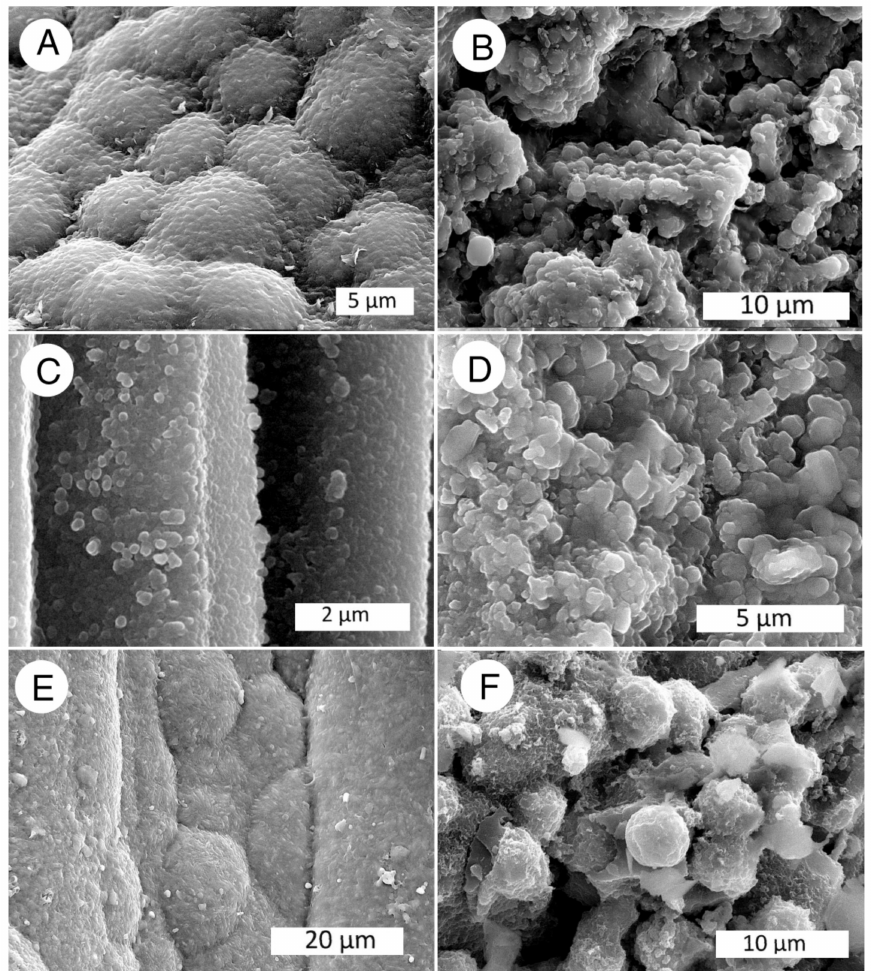
Figure 44. SEM images showing relict textures in silicified wood. ( A , B ) Chalcedony-mineralized Protoyucca wood showing relict opal lepisphere morphology, Miocene, Badger Flat, northeastern Nevada, USA. Specimen from Jim Mills. ( C ) Tangential view of chalcedony wood showing relict opal texture, Eocene, Blue Forest, Eden Valley, Wyoming, USA. Specimen from Mike Viney. ( D ) Relict opal textures in chalcedony wood, Eocene, Yellowstone River, Montana, USA. ( E ) Chalcedony wood showing relict botryoidal opal-CT morphology, Miocene, northwestern Iran. Specimen from Nasrollah Abbassi. ( F ) Relict opal-CT lepispheres in chalcedony wood, Miocene, Stonewall Pass, central Nevada, USA. Specimen from Patricia